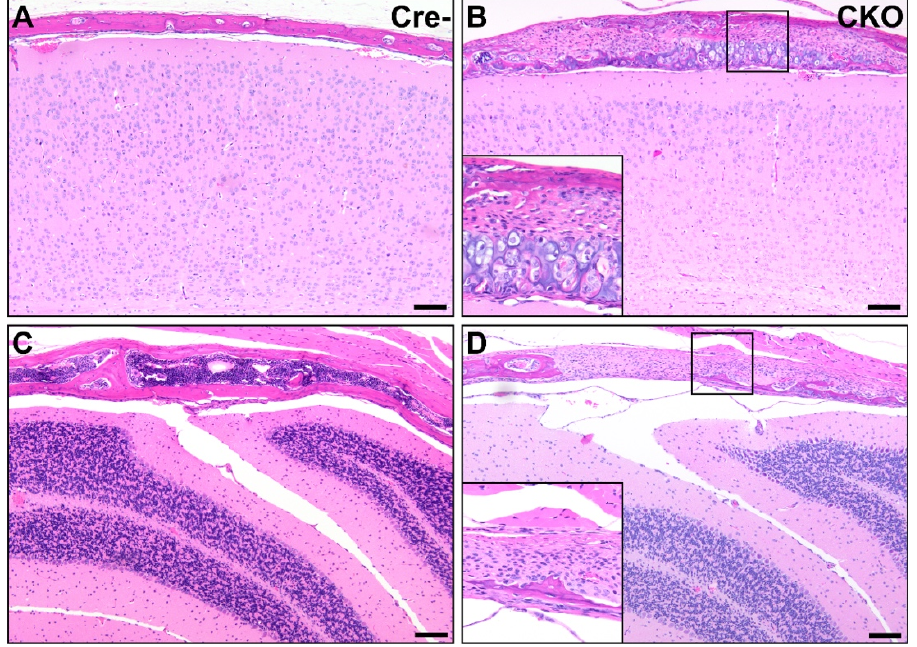
Figure 6. Osteochondral dysplasia in multiple bones of the calvaria in CKO mice. Compared to Cre- age-matched control mice ( A , C ), multiple bones were affected in CKO mice, including the parietal bone ( B ) and interparietal bone ( D ). Lesions similar to the osteochondral dysplasia observed elsewhere and consisting of variable amounts of bone, cartilage, fibrous connective tissue, and precursor-like cells were present in some areas ( B ), while in others, the bone was segmentally absent, with the brain encased only by fibrous connective tissue and precursor-like cells ( D ). Insets in ( B , D ) provide higher magnification views. The photos shown in ( A , B ) were taken mid-parietal at the level of the middle hippocampus, while ( C , D ) were taken mid-interparietal over the cerebellum. Scale bars = 100 µm.